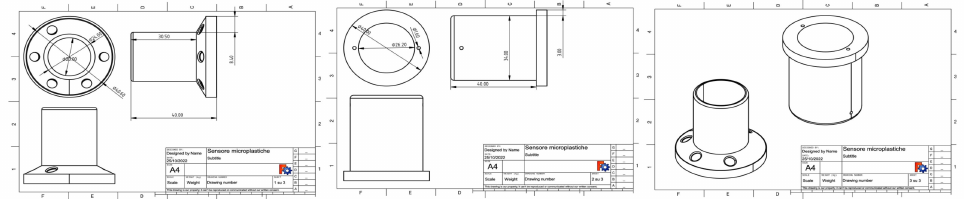
Figure 6. Schematic representation of the technical design of the microplastics sensor. Figures are not readable, but they are available from the authors on request.